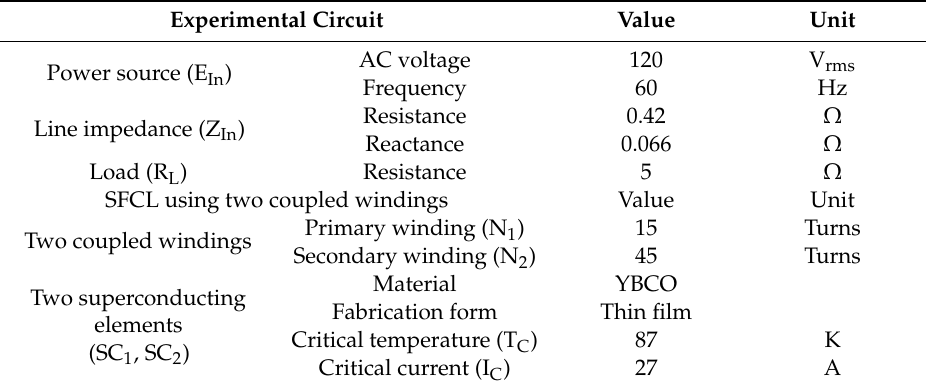
Figure 3. Experimental circuit for the short-circuit test of the SFCL using two magnetically coupled windings. Table 1. Specifications of the experimental circuit and the SFCL with two coupled windings.